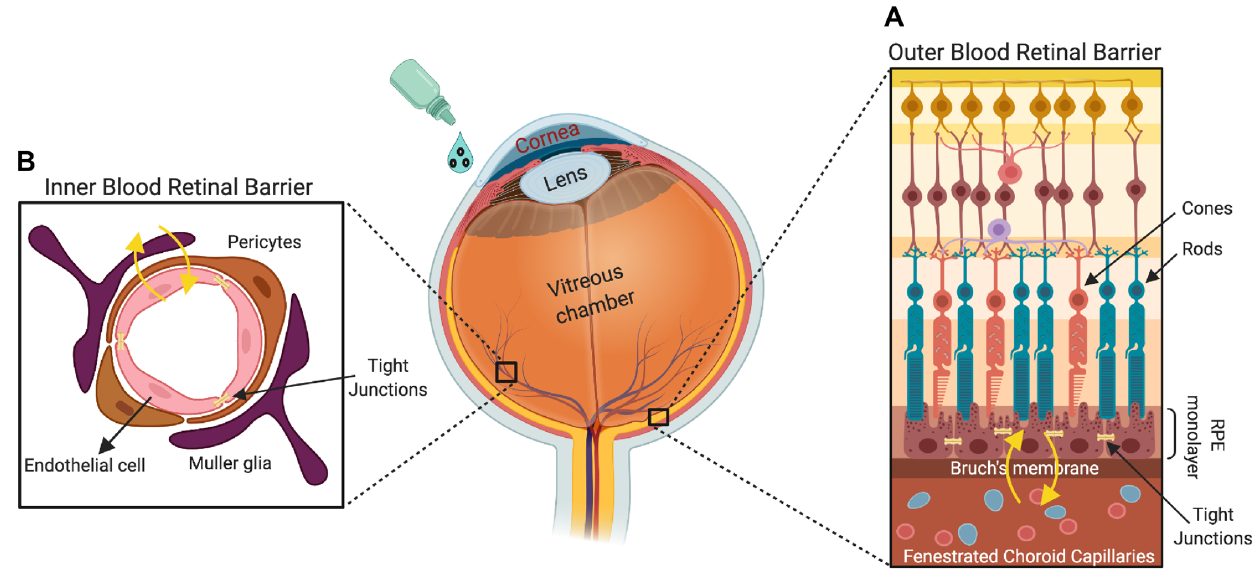
Figure 1. The retina is the innermost multilayered light-sensitive region of the eye, which has multiple barrier systems to regulate molecule, ion, and water flux out of the retina. The blood–retinal barrier is composed of two components: ( A ) the outer blood–retinal barrier, which comprises tight junctions that regulate paracellular trafficking between pigment epithelial cells, and ( B ) the inner blood–retinal barrier (comprising Müller cells, pericytes, and endothelial cells) formed by tight junctions that plug neighboring capillary endothelial cells. The tight junctions between retinal pigment epithelial and capillary endothelial cells form the outer and inner blood–retinal barriers, respectively, and these barriers regulate the retinal homeostasis and visual function.